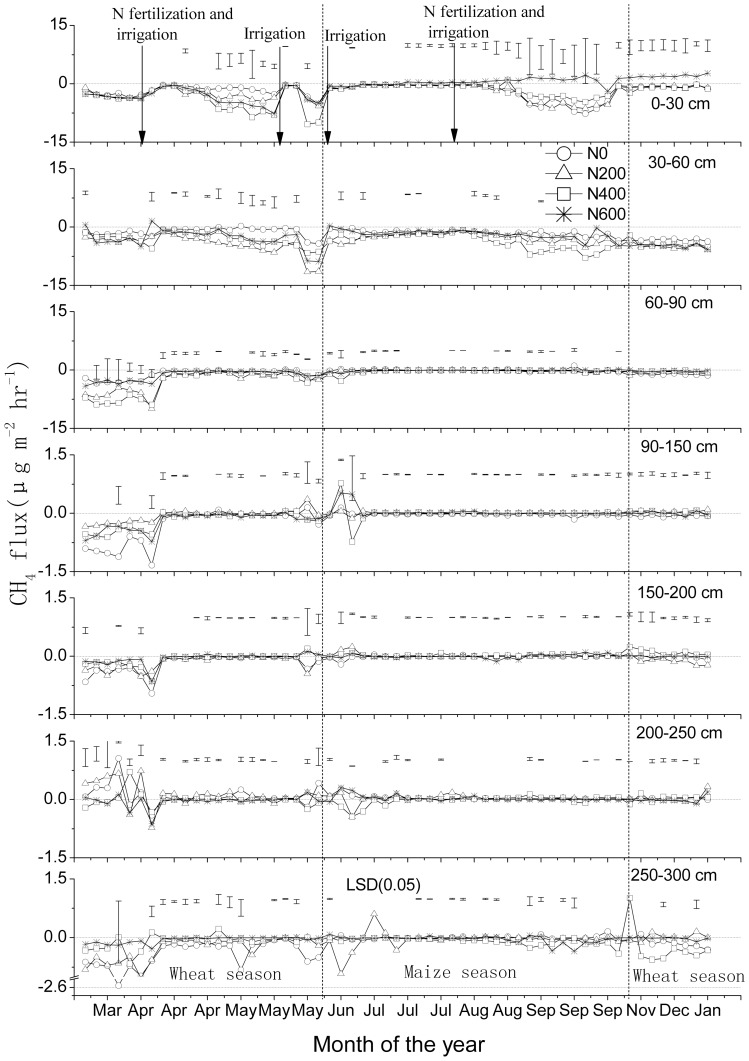
CH4 flux rates (means ± standard deviations, n = 3) at various soil depths in a winter wheat-summer maize double cropping rotation receiving 0, 200, 400 and 600 kg of N ha−1 year−1, in 2007–2008.Vertical dashed lines indicate a change in crop. Bars in figures indicate 1 standard deviation (n = 3). Note the differences in Y-axes.